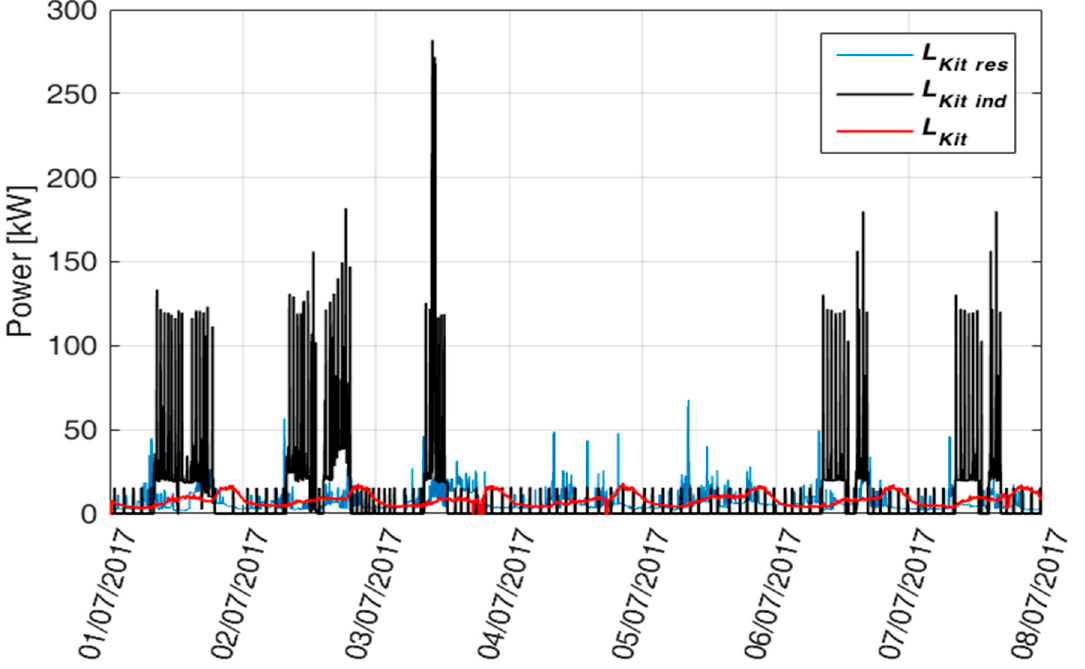
and 𝑳 𝑲𝒊𝒕 ) electric load profiles shown for a time interval of 1 week (1 min 𝒓𝒆𝒔 𝒊𝒏𝒅